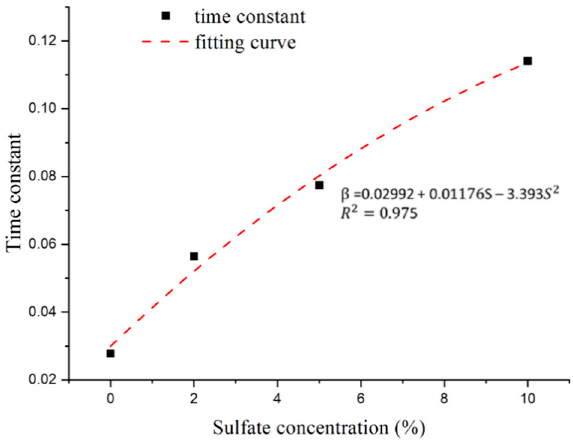
Figure 15. Relationship between sulfate concentration and time constant.